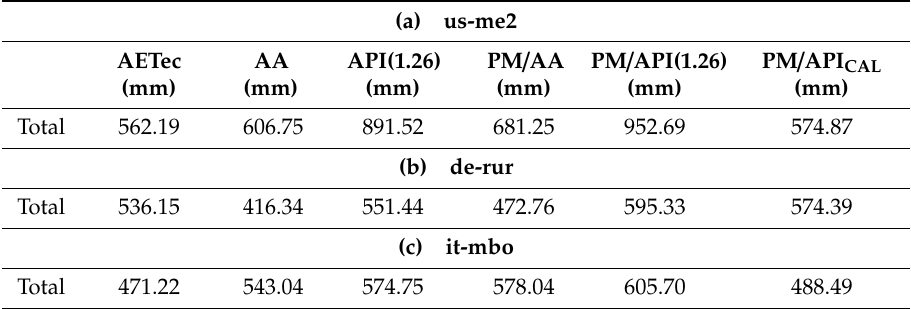
Table 2. Annual actual evapotranspiration losses from the EC flux data (AETec) and from the compared meteorological data-based approach models (AA = advection-aridity method; API (1.26) = API corrected potential evapotranspiration, with α = 1.26; PM / AA = Penman / advection-aridity threshold model;